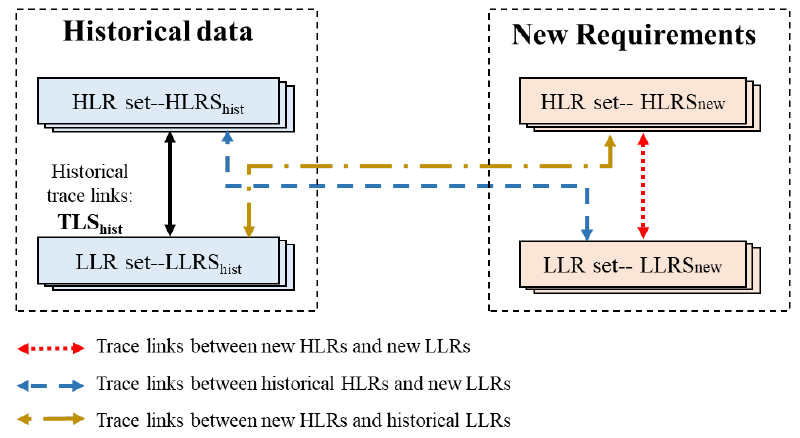
Figure 4. Identifying the source and target of the trace link for new requirements.